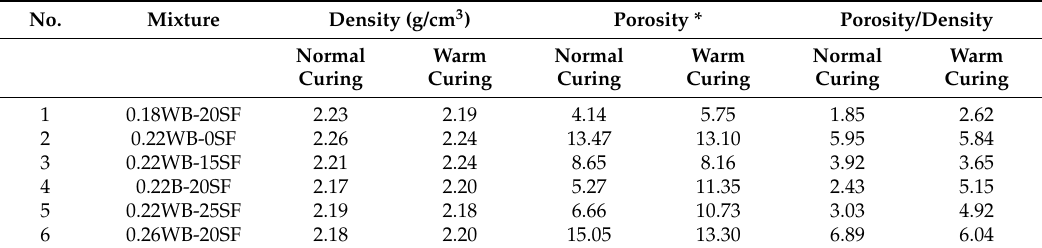
Figure 10. Effect of SF and curing temperature on flexural strength. Table 4. Density and porosity test results.